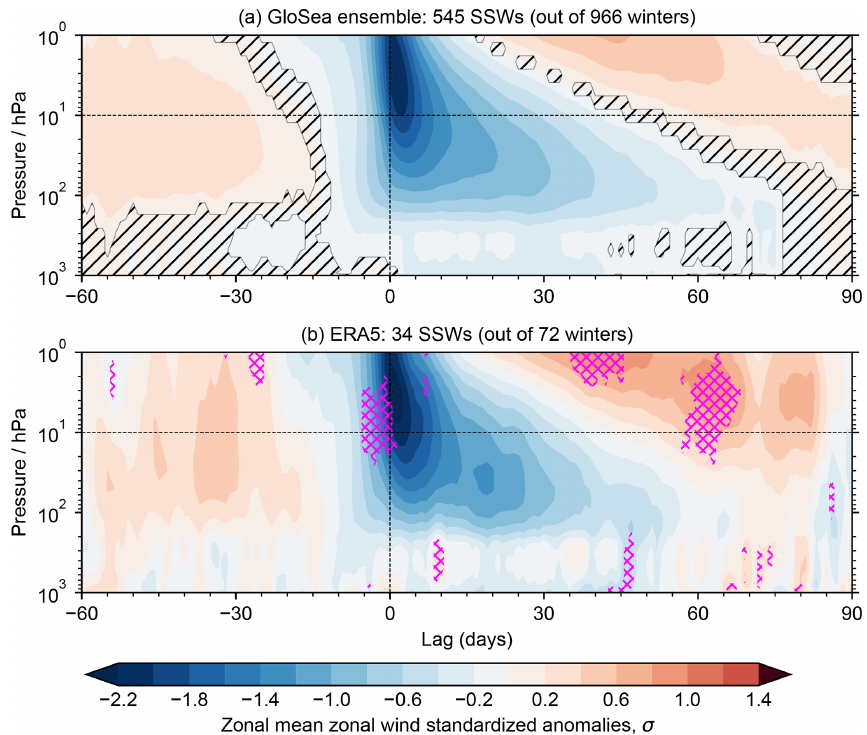
Figure 2. Development of zonal-mean zonal-wind anomalies associated with SSWs in (a) models and (b) observations. Both panels show composite mean standardised anomalies in the 60 ◦ N zonal-mean zonal-wind profiles, with each contributing winter centred at their SSW date (lag = 0). Only dates in DJFM contribute; the composite comprises fewer SSWs at large lags/leads. In the model panel (a) , areas are hatched where the anomalies are indistinguishable from zero. In the observation panel (b) , pink cross-hatching marks where the anomalies exceed the 95% range of the hindcast resamples.